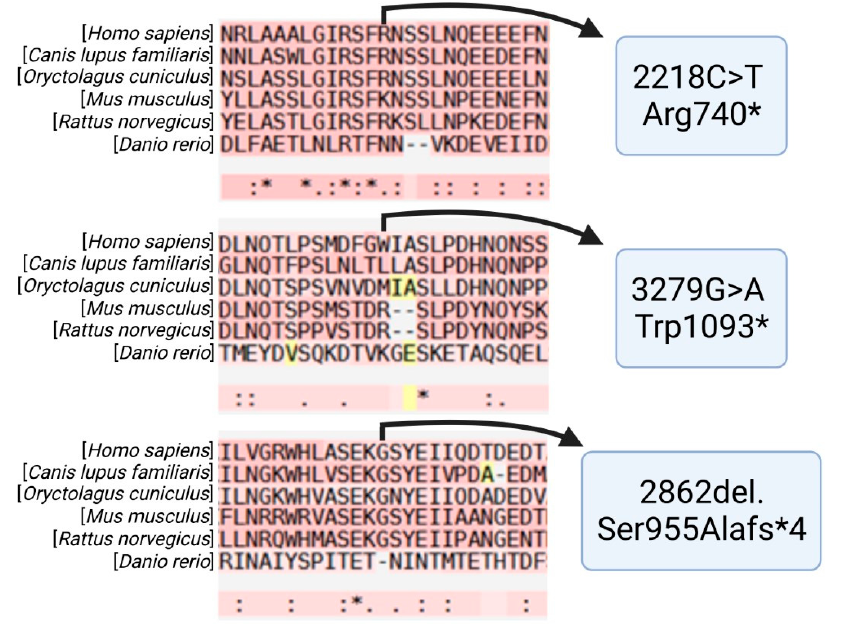
Figure 6. Multiple sequence alignment comparing the different regions of FVa corresponding to the 2218C>T Arg740, 3279G>A Trp1093* and 2862del, Ser955Alafs*4 mutations in Homo sapiens , Canis lupus familiaris , Oryctolagus cuniculus , Mus musculus , Rattus norvegicus and Danio rerio . The mutated amino acid is at the center, with an arrow pointing to it. The three mutations described in the two patients are in exon 13, corresponding to the protein’s B domain, and in well-conserved regions across the different vertebrate species analyzed. Created in Biorender.com (accessed on 6 September 2021).